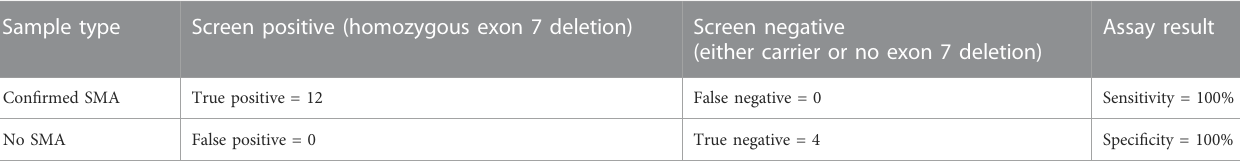
TABLE 1 Results of SMA NGS screening of blinded positive and negative controls. Sample